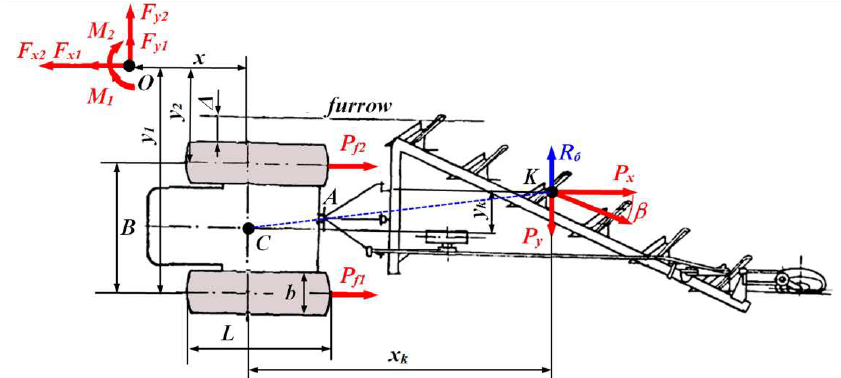
Figure 1. A diagram of the forces acting on the plowing